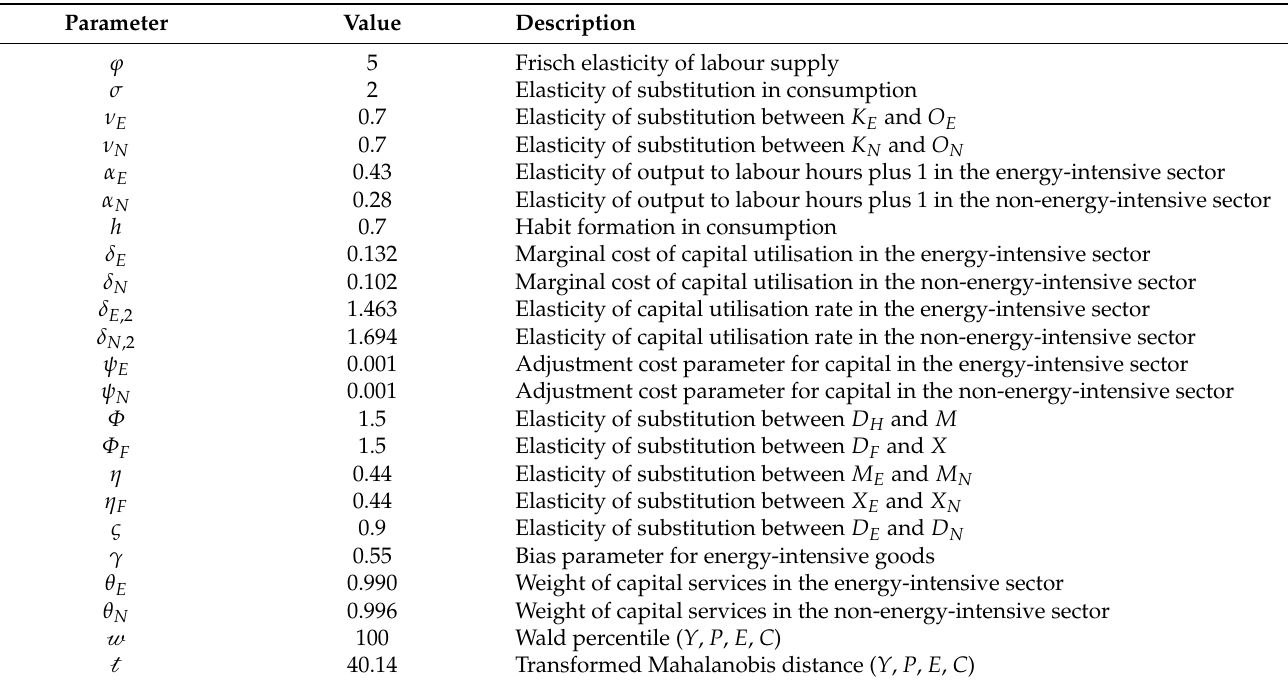
Table A1. Table A1. Initial parameter values used to start the simulated annealing